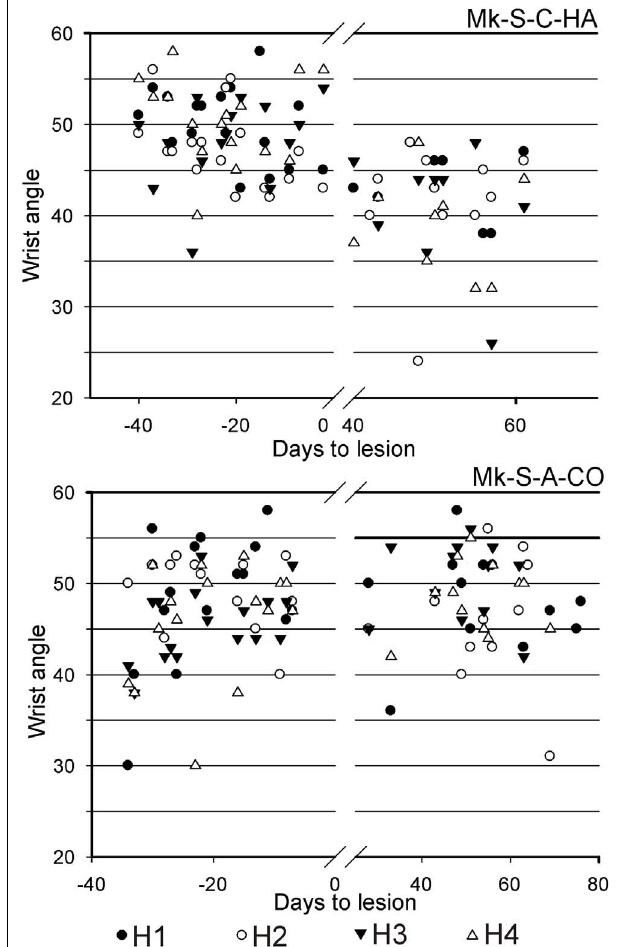
FIGURE 5 | For movement type HMT1, used to retrieve pellets from the horizontal slots, the wrist angle measured for the hand affected by a cervical cord lesion was plotted as a function of time, corresponding to a daily behavioral session, pre-lesion (negative days) or post-lesion (positive days) .The data are presented here for two representative monkeys. On top, in Mk-S-C-HA, there was a change of wrist angle when comparing the movement pre-lesion versus post-lesion (decrease of wrist angle post-lesion). In contrast, in Mk-S-A-CO, the wrist angle was comparable pre- and post-lesion. See Table 2 for statistical analysis on all monkeys and all horizontal wells’